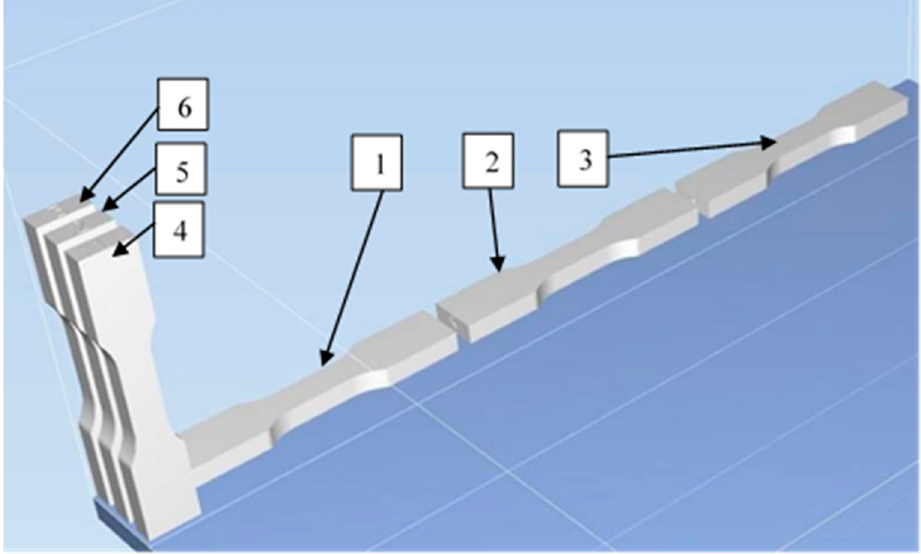
Figure 1. Specimen arrangements during the printing process; three (1–3) printed horizontally (X) and three (4–6) printed vertically (Z). and three (4–6) printed vertically